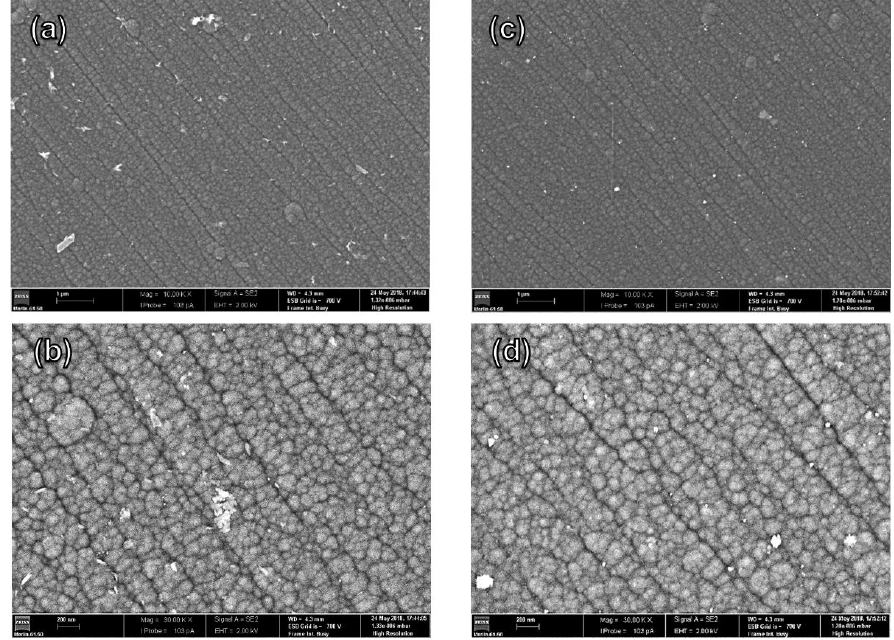
Figure 10. SEM surface micrographs of the a-C:5H coatings deposited on SS310 substrates after the corrosion tests at ( a , b ) pH = 6.8; and ( c , d ) pH = 2.3.